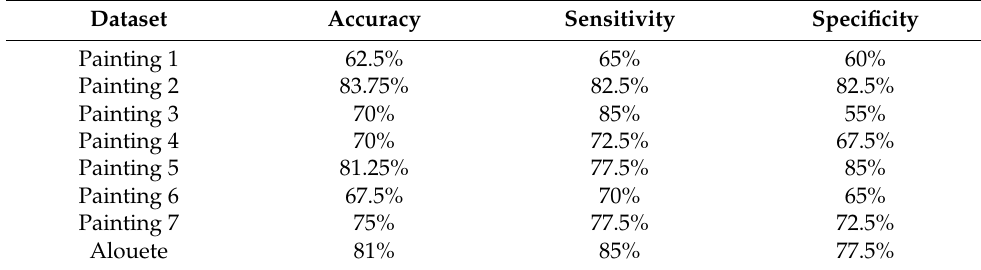
Table A3. Support vector machine scores for the two grouped paintings dataset using AIDEAL eye